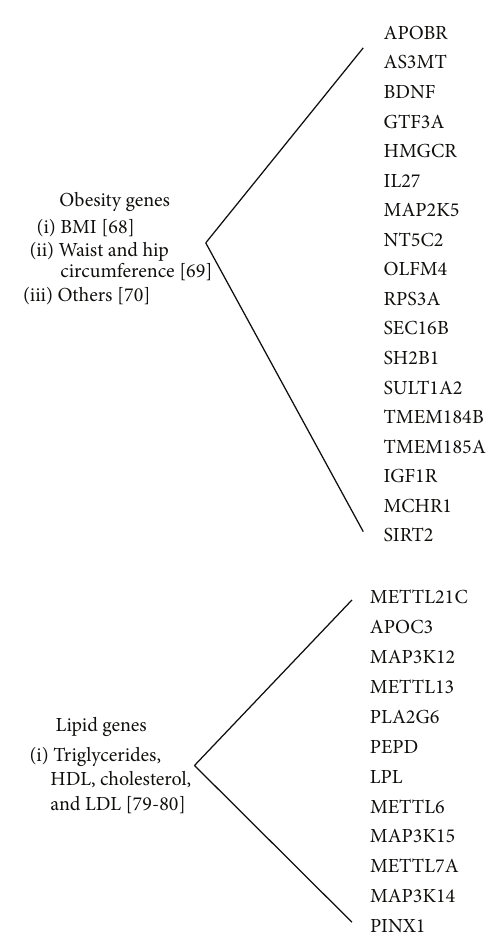
Table 1: Location of FXR and MAFA consensus binding sequences within 1000bp of complement alternative activation pathway genes.